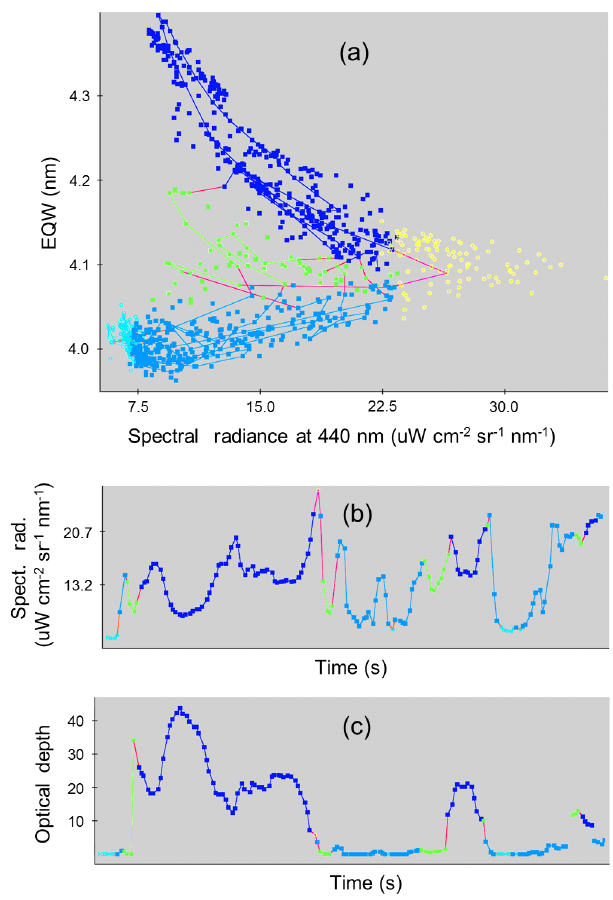
Figure 13. (a) Nose plot of data taken over several minutes. The col- ors are described in the text. Simultaneous time plots of (b) spectral radiance at 440nm and (c) retrieved optical depth corresponding to the nose plot (a)